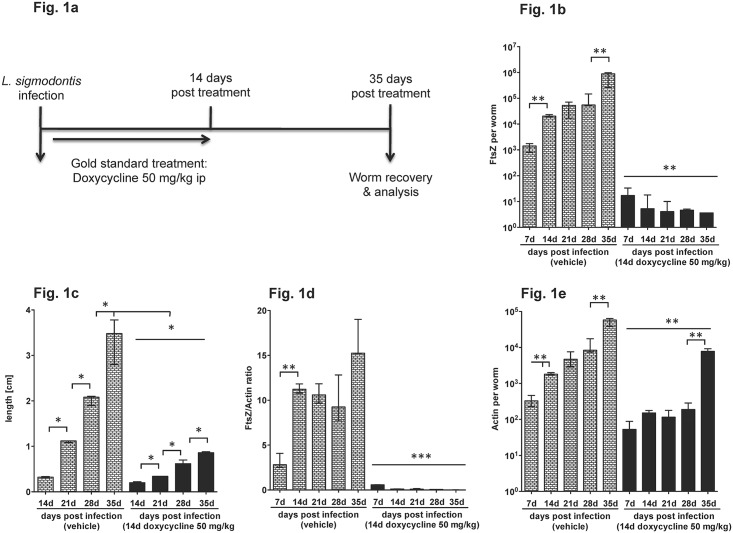
Wolbachia depletion and reduction in worm length after doxycycline treatment.(a) Experimental set up for investigation of anti-Wolbachia compounds. BALB/c mice are naturally infected with the filarial parasite Litomosoides sigmodontis and treatment starts the following day. As positive control 50mg/kg/d doxycycline (DOX) and vehicle as negative control were administered for 14 days intraperitoneally. At 7–35 days post infection worms were recovered from the pleural cavity, staged, measured for length and DNA was extracted and analysed for Wolbachia FtsZ and L. sigmodontis actin from single female worms. FtsZ copy numbers (b), female worm length (c), filarial actin copy numbers (d) and the FtsZ/actin ratio (e) are given from worms recovered from mice receiving DOX intraperitoneally at 50 mg/kg/d for 14 days. Worms were recovered at 7, 14, 21, and 35 days post infection. Significances were tested with Mann-Whitney-U test. *p<0.05; **p<0.01; ***p<0.001.